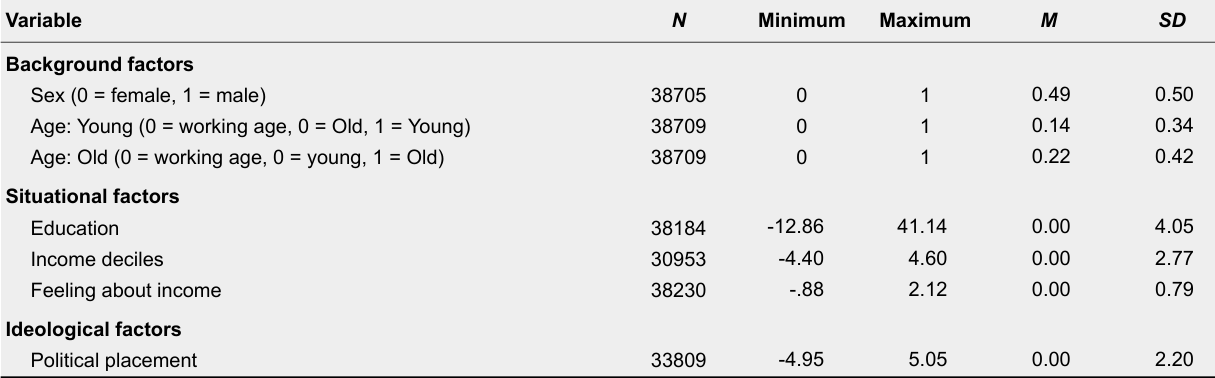
Independent Individual Level Variables (Grand Mean Centered, Except Sex and